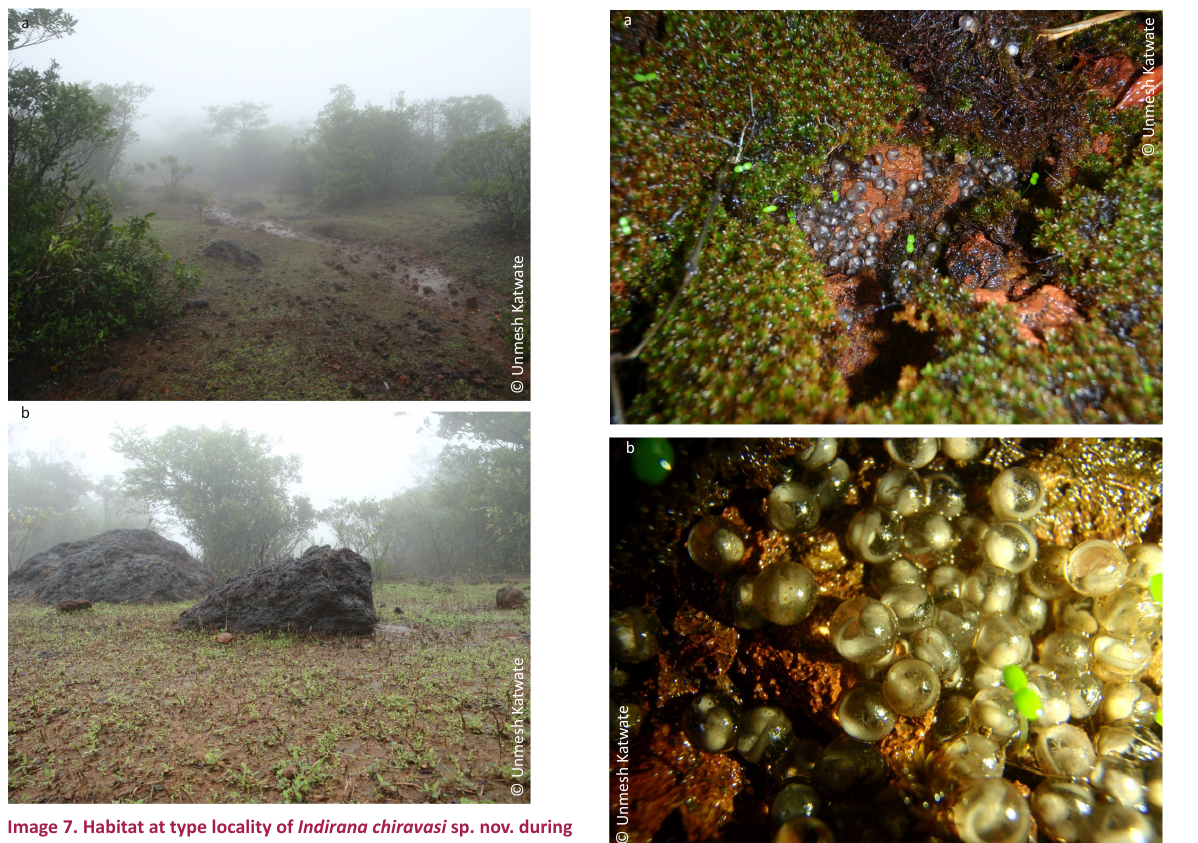
Image 7. Habitat at type locality of Indirana chiravasi sp. nov. during monsoon season. (a) General habitat on lateritic plateau and (b) lateritic rocks where adults, eggs and tadpoles are found in crevices and moss covered surfaces.